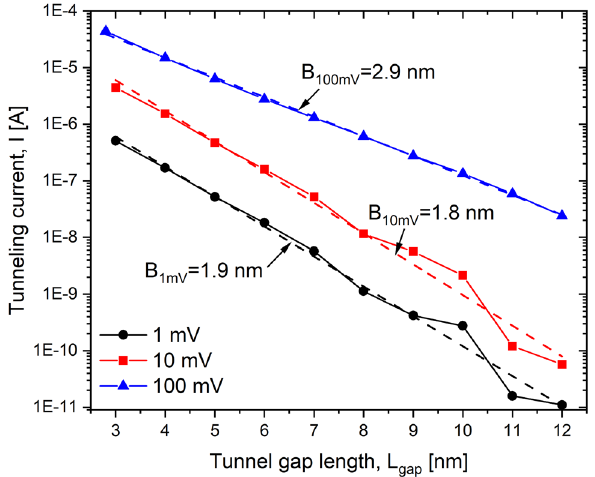
Figure 7. Characteristic tunneling current curves. The total current (logarithmic scale) I vs. tunnel gap length L gap for three different applied voltages of V N